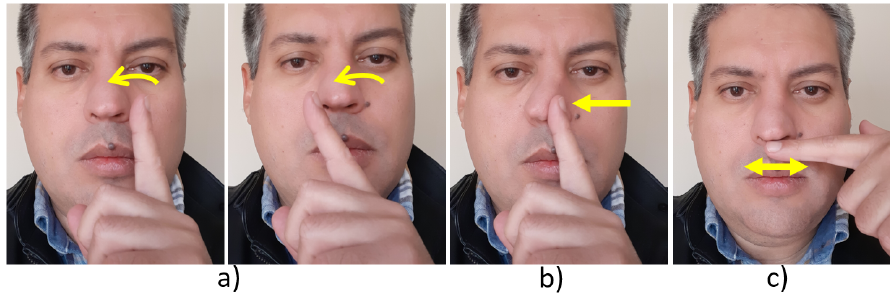
Figure 1. Examples of the ItchyNose [6,7] gestures: Flick ( a ), Push ( b ), and Rub ( c